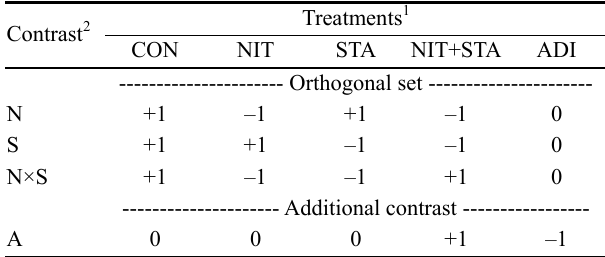
Table 2. Distribution of coefficients employed in the contrasts among treatments Contrast 2